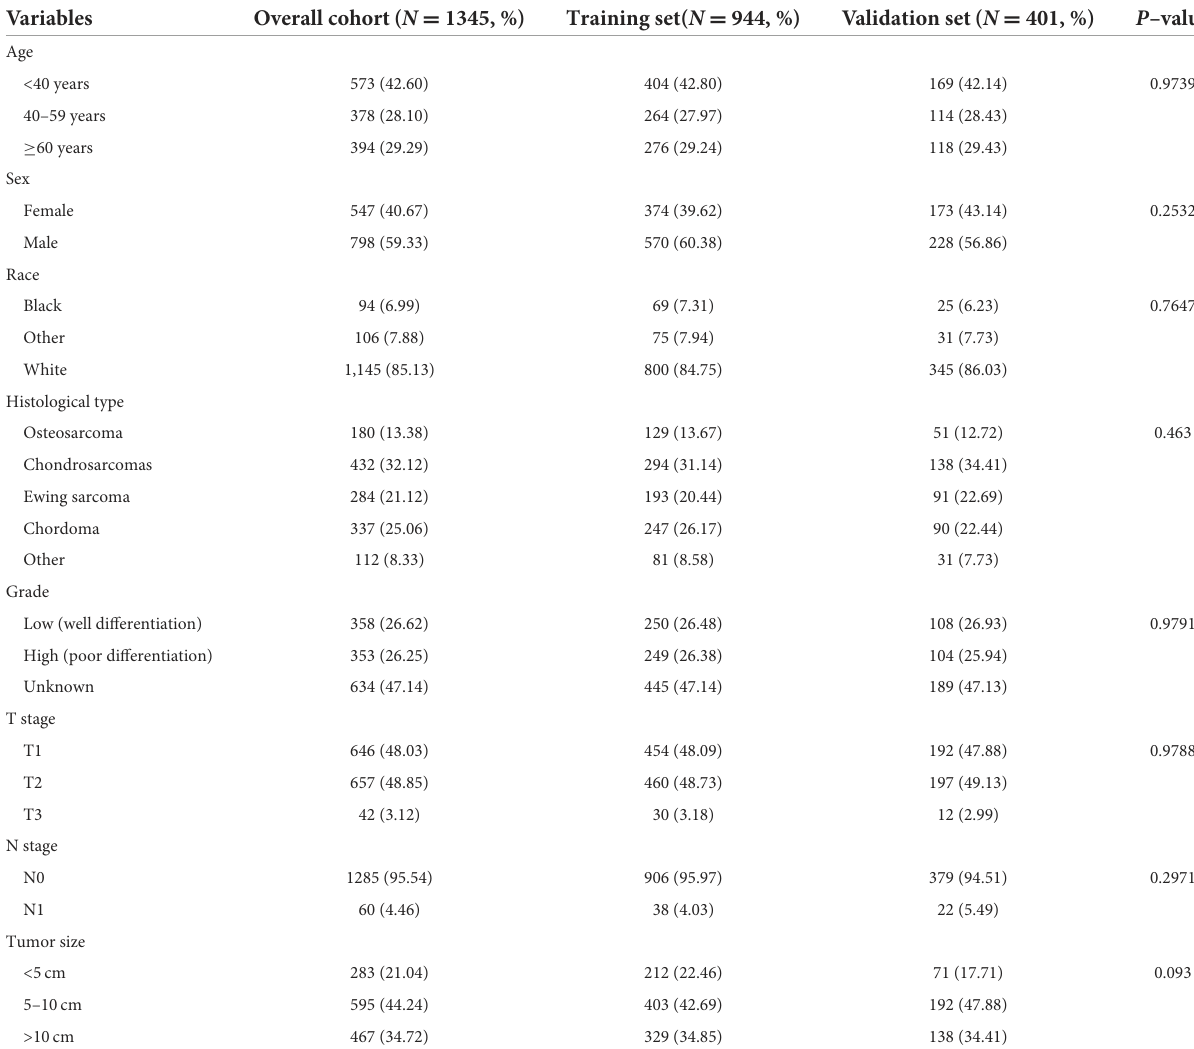
TABLE 1 The demographic and clinicopathological characteristics of the POSNs patients with or without